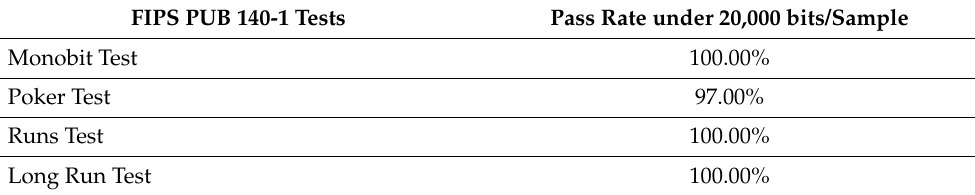
Table 10. Random Test Results under FIPS PUB 140-1.